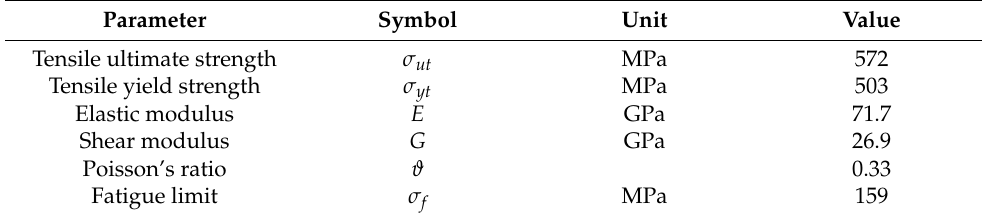
Table 2. Mechanical properties of 7xxx series aluminum alloy (Al 7075-T6) [5].